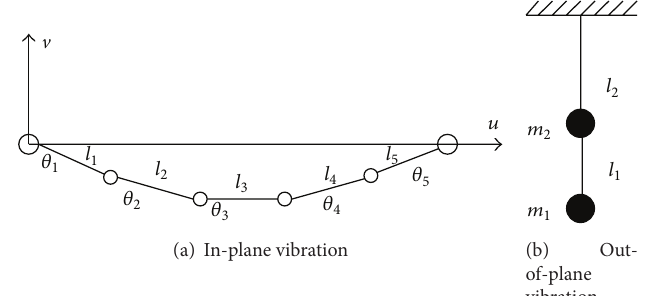
Figure 2: MDOF elastic model of a transmission